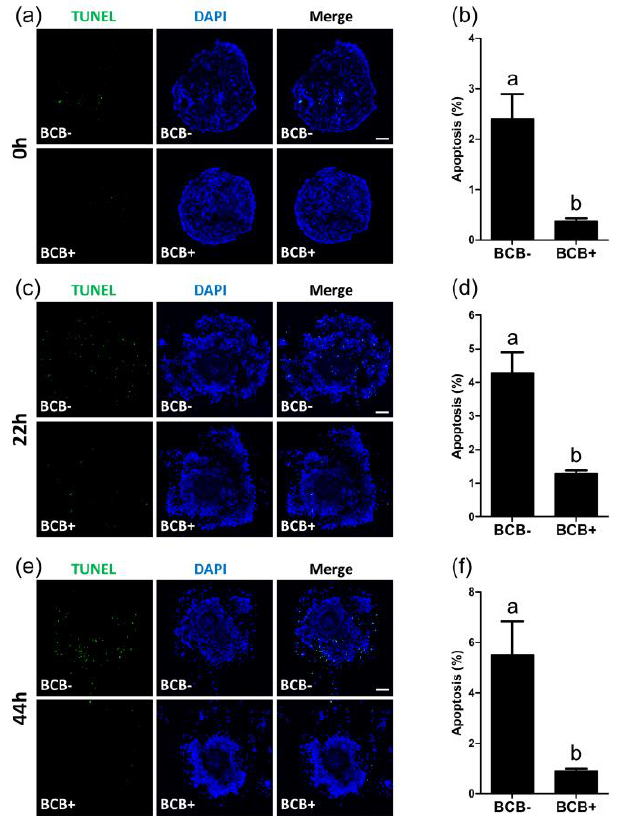
Figure 3. Detection of cellular apoptosis during the in vitro maturation of BCB- and BCB+ porcine cumulus-oocyte complexes (COCs), as detected by TUNEL staining. Representative TUNEL (green) assay images of COCs and quantification of TUNEL positive cells in BCB- and BCB+ COCs, after 0 h ( a and b ), 22 h ( c and d ), and 44 h ( e and f ) of in vitro maturation. Within each category, groups marked with different letters are significantly different ( p < 0.05). Bar = 100 μM.